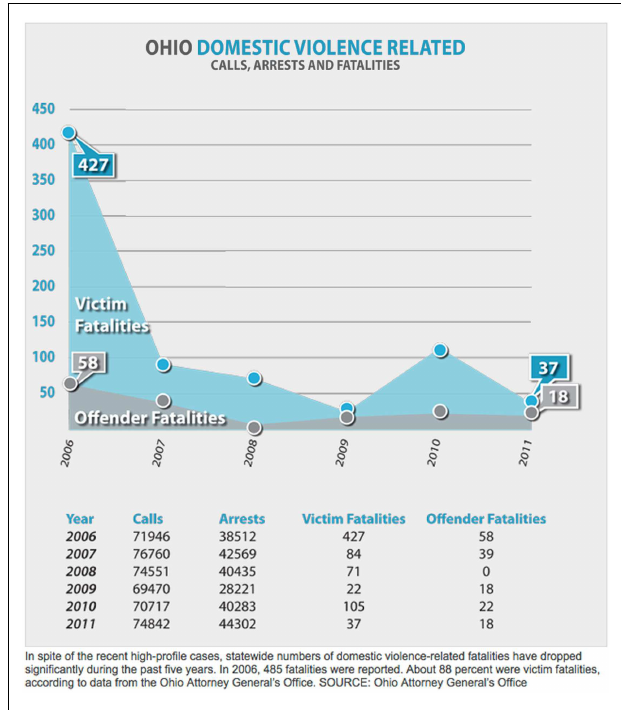
FIGURE 1 | Ohio domestic related violence facts 2006–2011